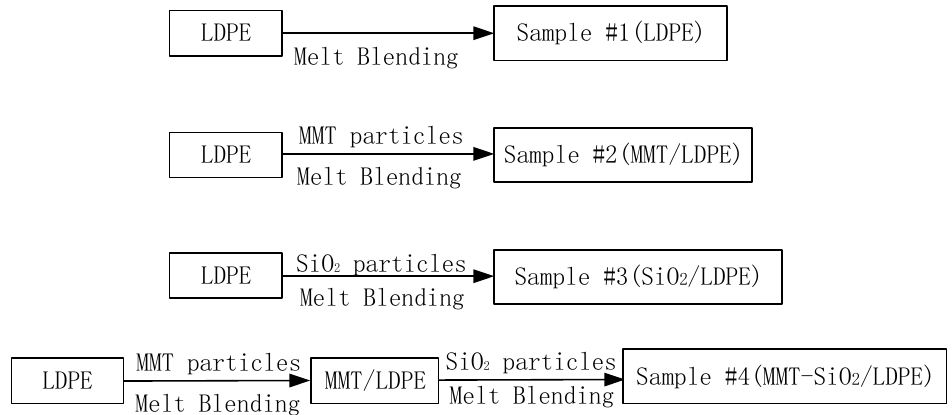
Figure 1. Material preparation